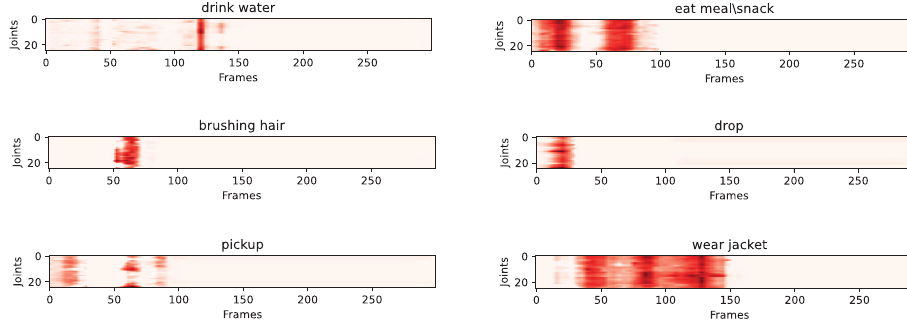
Figure 7. Keyframes and node heatmaps for several types of actions.